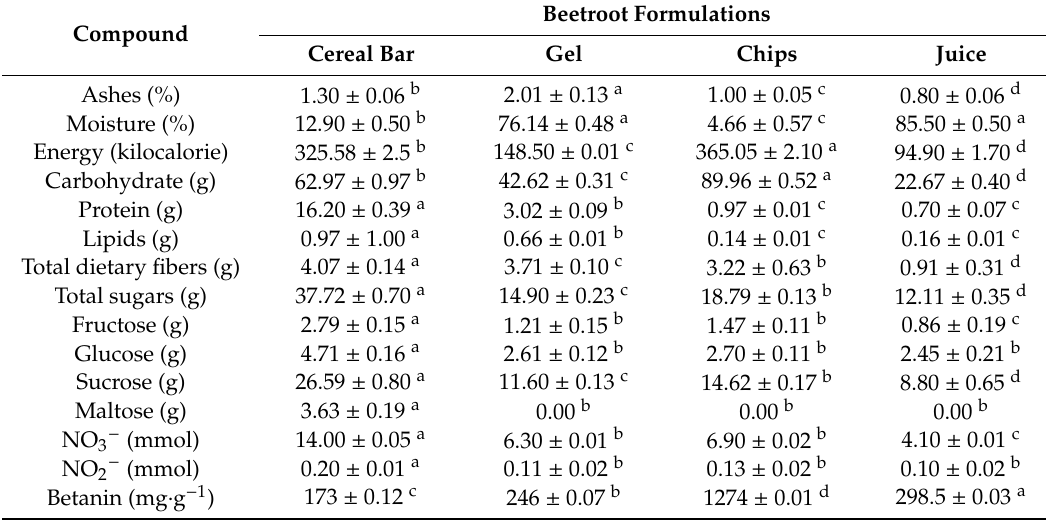
Table 1. Proximate composition, sugars, NO 3 − , NO 2 − , and saponin contents of beetroot formulations in 100 g of each